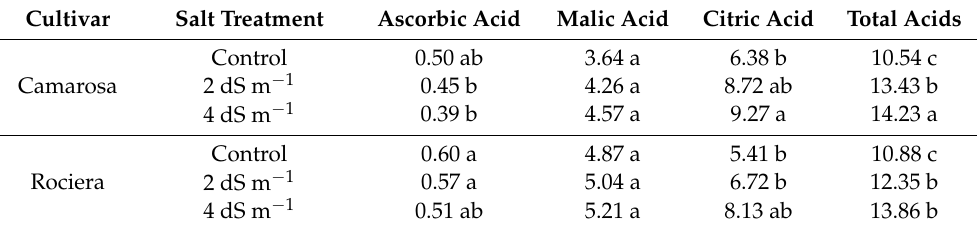
Table 8. Effect of salt stress on the strawberry fruit organic acid content (expressed as mg g − 1 fresh weight).